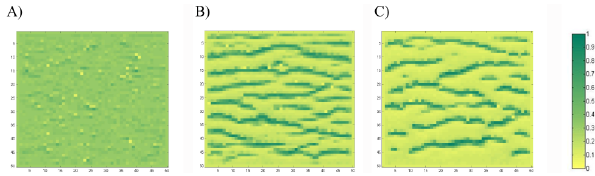
Fig. 12. Effect of precipitation on pattern formation. (A) P = 32cmyr − 1 ; (B) P = 48cmyr − 1 ; (C) P = 70cmyr − 1 .